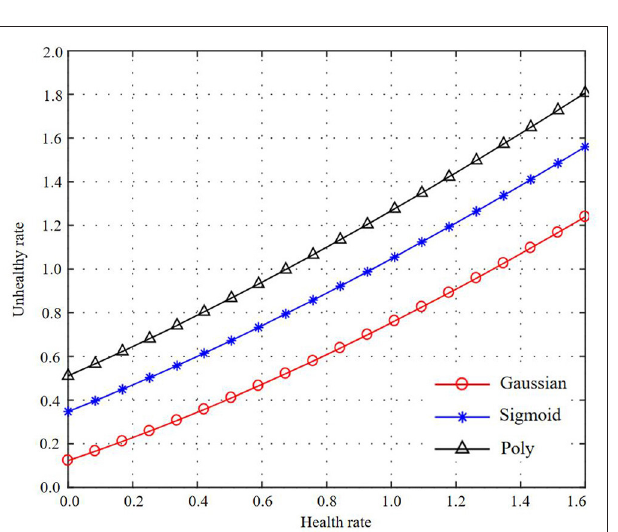
FIGURE 7 | Curve representation of three kernel functions of machine learning basic data and health information